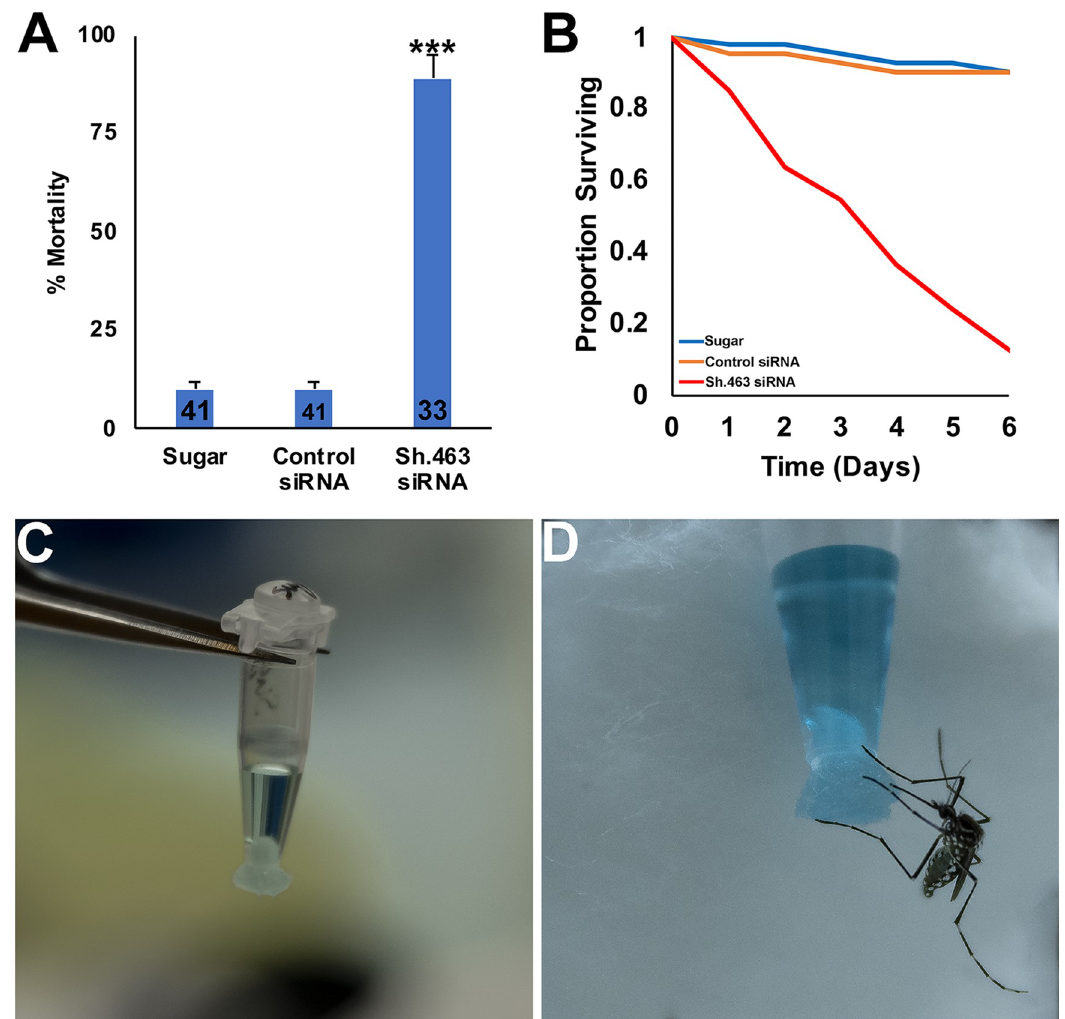
Fig 3. Delivery of Sh.463 siRNA as an ATSB induces high adult mortality. A. Sh.463 siRNA consumed as an ATSB by adult females induced significantly high adult mortality in comparison to sugar bait alone (Sugar) or sugar bait with control siRNA (Control). ��� = P < 0.001 vs. both Sugar and Control, which were not significantly different from each other; error bars represent SEM. B. A survival curve for adults that fed on sugar bait, control siRNA sugar bait, or Sh.463 sugar bait is shown. C. The delivery system for sugar bait marked with blue tracer dye is shown. D. An A . aegypti female feeding from the sugar bait station is